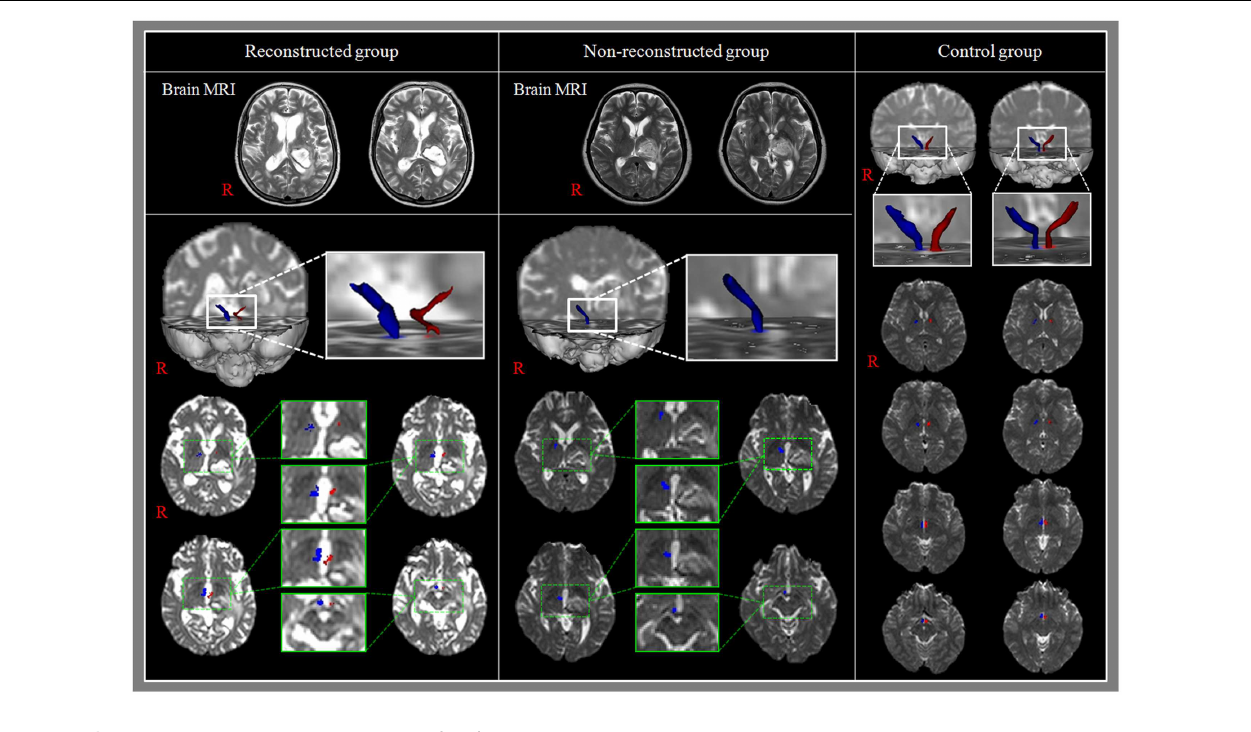
FIGURE 2 | Results of diffusion tensor tractography (DTT) for the mammillothalamic tract (MTT). Reconstructed group:T2-weighted brain MR images show the left thalamic hemorrhage and MTTs are reconstructed in both hemispheres. In addition, the MTT in the affected